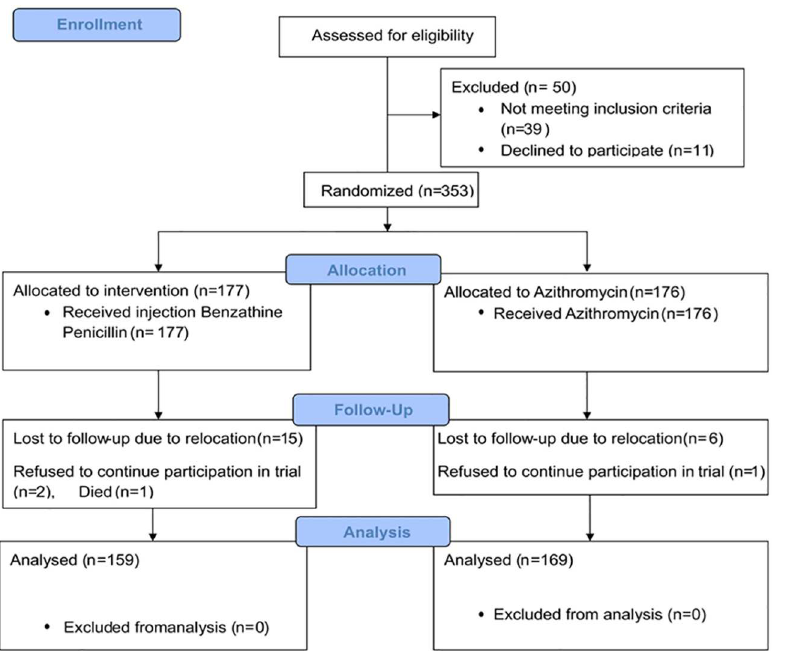
Fig 2. Trial Profile: Flow of patients through various stages of trial.